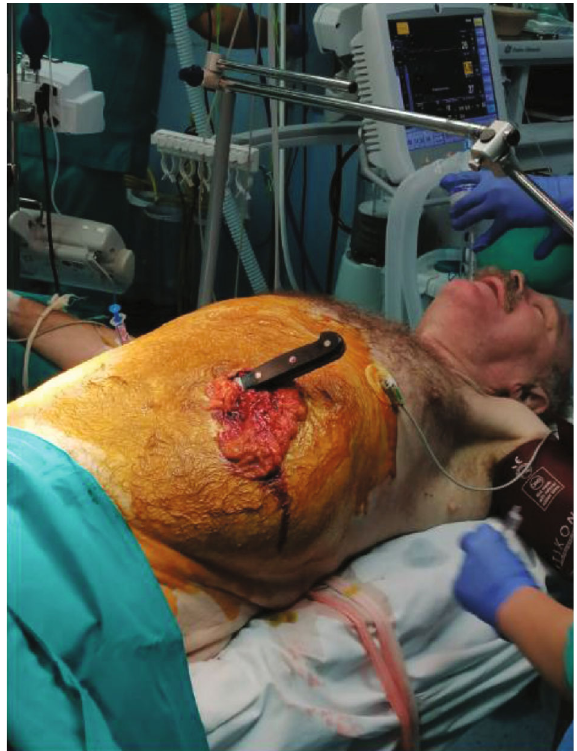
Figure 1: The patient on the operating table — the wound in the left hemiabdomen with the weapon in situ and omental evisceration are